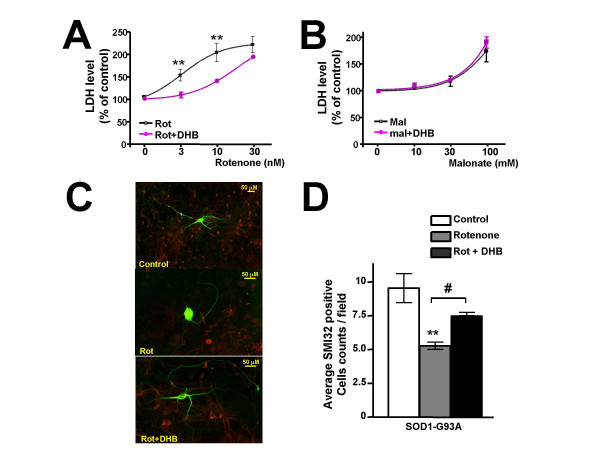
Neuroprotective effects of DBH on spinal cord motor neurons. (A) Effect of DHB on rotenone mediated toxicity. Primary spinal cord neurons from SOD1-G93A mice were cultured in the presence or absence of DHB (5 mM) and exposed to rotenone and cell toxicity measured by LDH activity released in the culture media expressed as a percentage of control (data = mean ± se; Rot: n = 4, Rot+DHB: n = 4; ** - p < 0.01, Rot vs. Rot+DHB). (B) Absence of neuroprotection of DHB in SOD1-G93A cultures exposed to malonate expressed as a percentage of control (data = mean ± se; Mal: n = 4, Mal+DHB: n = 4). (C) Photomicrographs of representative staining of motor neurons using SMI-32 antibody in control (top), rotenone (middle) and rotenone and DHB (bottom) treated spinal cord cultures. Motor neurons are SMI32 positive and characterized by their large cell bodies and numerous dendrites. (D) The effect of DHB on chronic mitochondrial toxicity by rotenone. Spinal cords neurons from SOD1-G93A were cultured in the presence or absence of DHB (5 mM) and treated with rotenone (3 nM) (data = mean ± se; Control: n = 4, Rotenone: n = 4, Rot+DHB: n = 4; # - p = 0.041, Rotenone vs. Rot+DHB; ** - p = 0.004, Rotenone vs. Control).